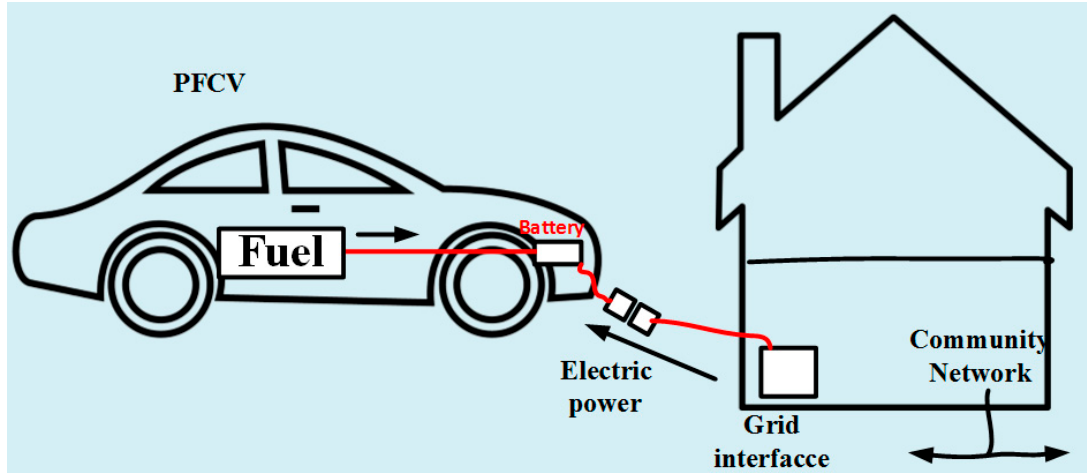
Figure 9. PFCV configuration. In addition to the fuel cells, this arrangement can directly charge the battery from a power outlet. Table 1. Comparison of different vehicle types. Adapted from [4].